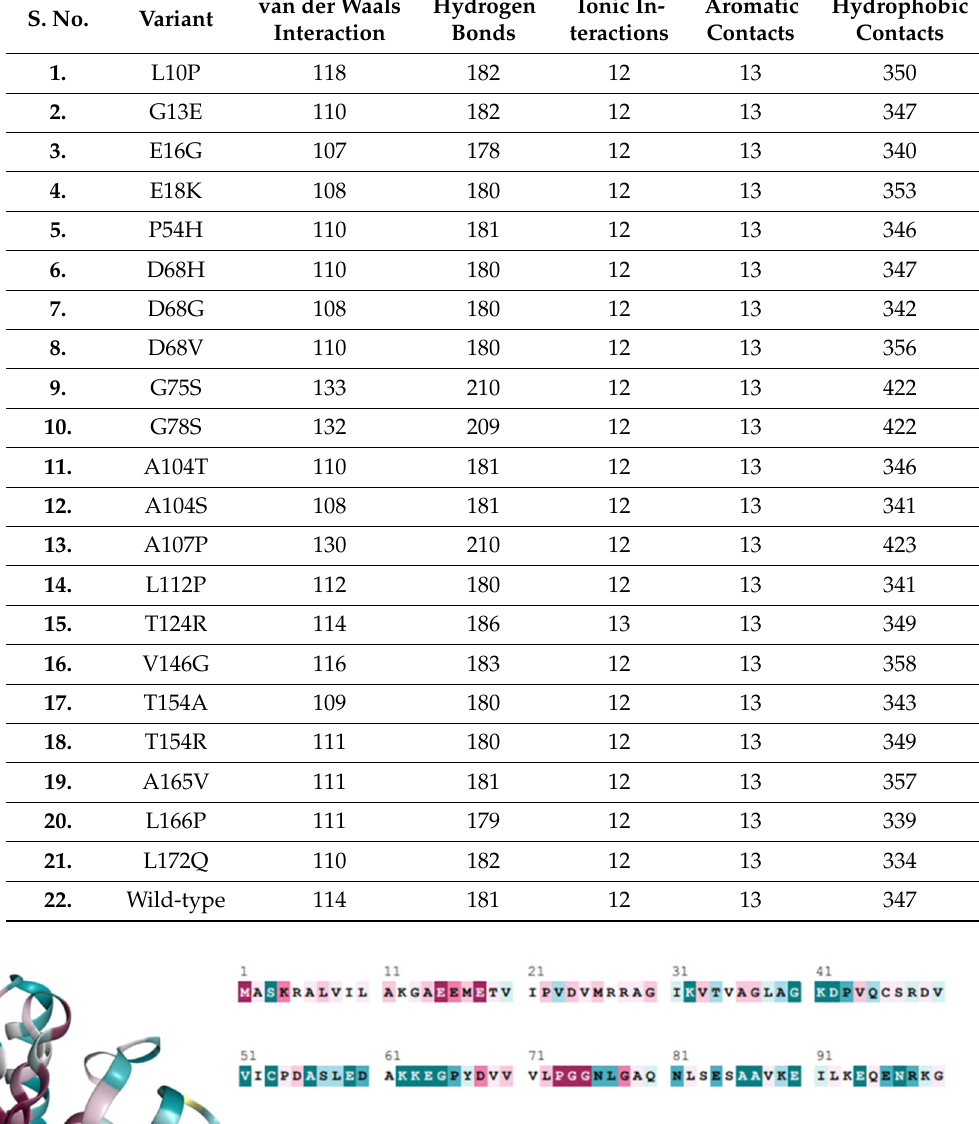
Table 4. Prediction of noncovalent bonds of mutants and wild-type PARK7 protein. S. No.